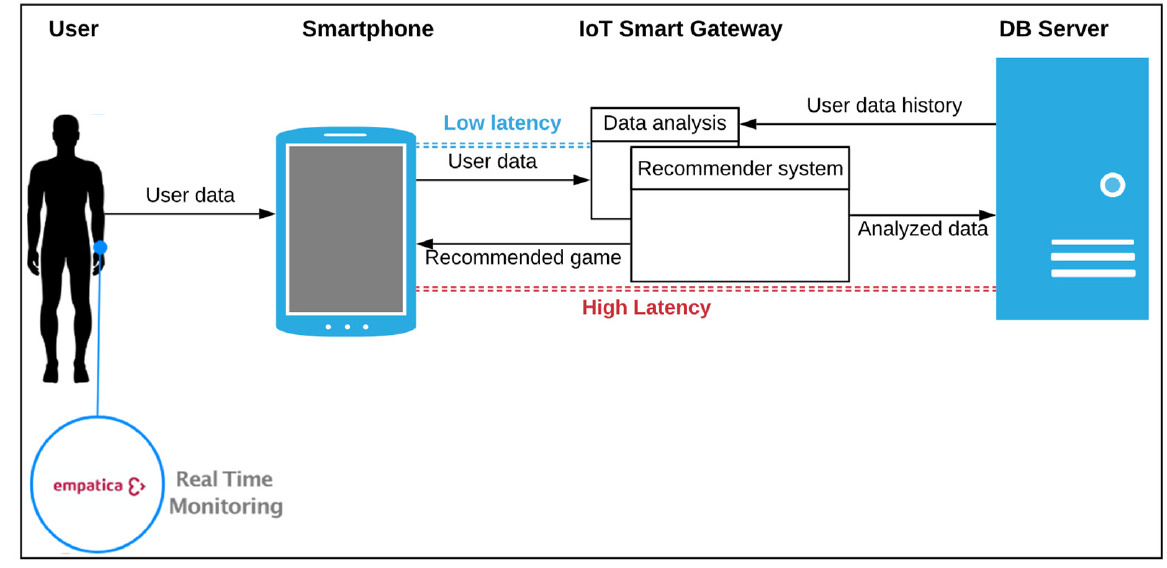
Figure 2. Proposed IoT system.